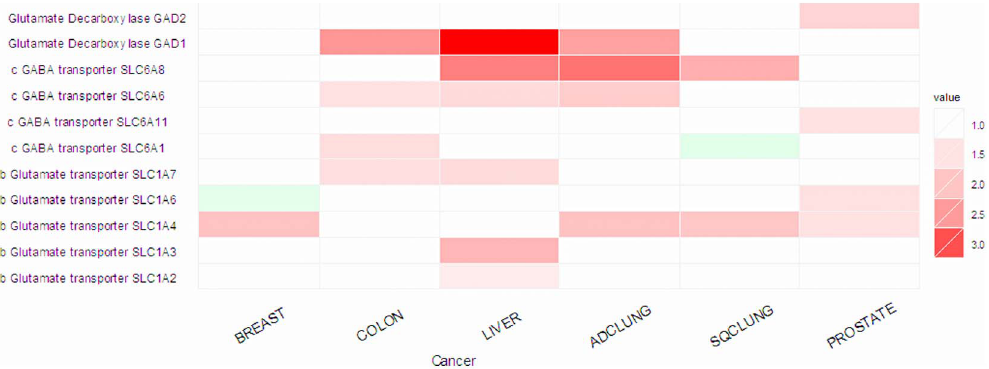
Figure 3. Expression level changes of genes involved in the conversion of glutamate to GABA and CO 2 , along with the genes encoding the GABA transporters.